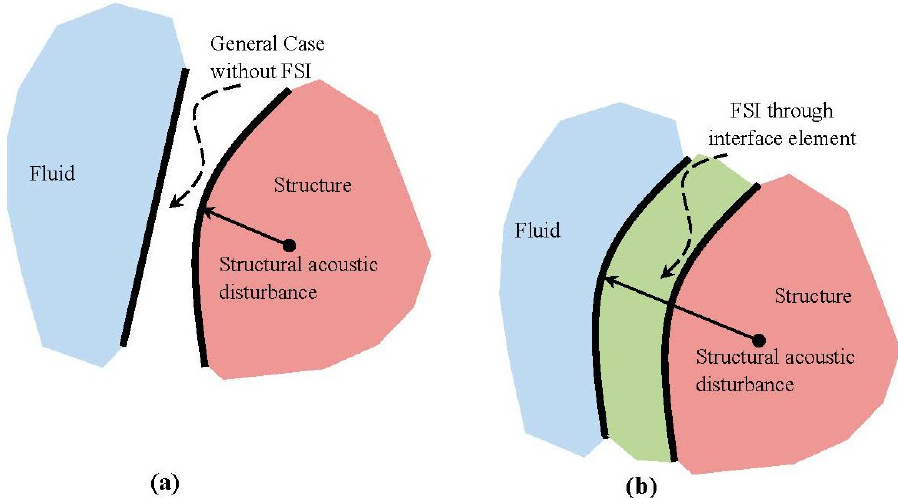
Figure 3. Coupling between the fluid and solid domains using an interface function; ( a ) decoupled structure and fluid elements; ( b ) coupled structure and fluid